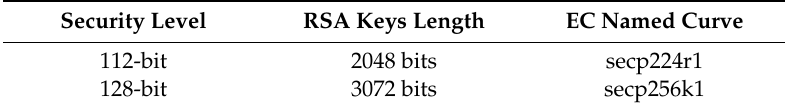
Mapping between the security level and corresponding type / length of endowed cryptographic